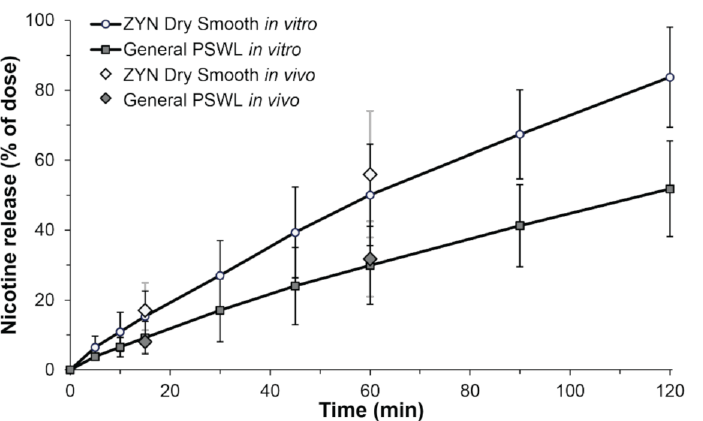
Figure 2. In vitro and in vivo nicotine release from ZYN Dry Smooth and General Pouched Snus White Portion Large (PSWL) as a function of time. Nicotine in vitro release profiles from General PSWL (dark gray squares, black error bars) and ZYN Dry Smooth (white circles, black error bars) in artificial saliva as % of dose ± standard deviation (SD) ( n = 12). Based on calculations of the difference ( f 1 ) and similarity factor ( f 2 ) the curves are distinct ( f 1 = 63.6, f 2 = 38.8). In vivo nicotine extraction after 15 min and 60 min for ZYN Dry Smooth (white diamonds, grey error bars) and General PSWL (dark grey diamonds, grey error bars) is added for comparison as % of dose ± SD ( n = 18). No significant differences were seen at 15 and 60 min between in vitro and in vivo conditions for both products,